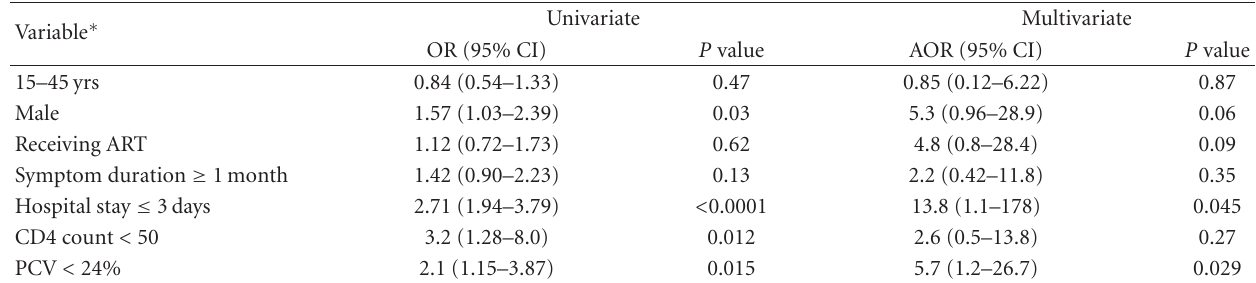
Table 6: Variables associated with mortality in hospitalised HIV/AID